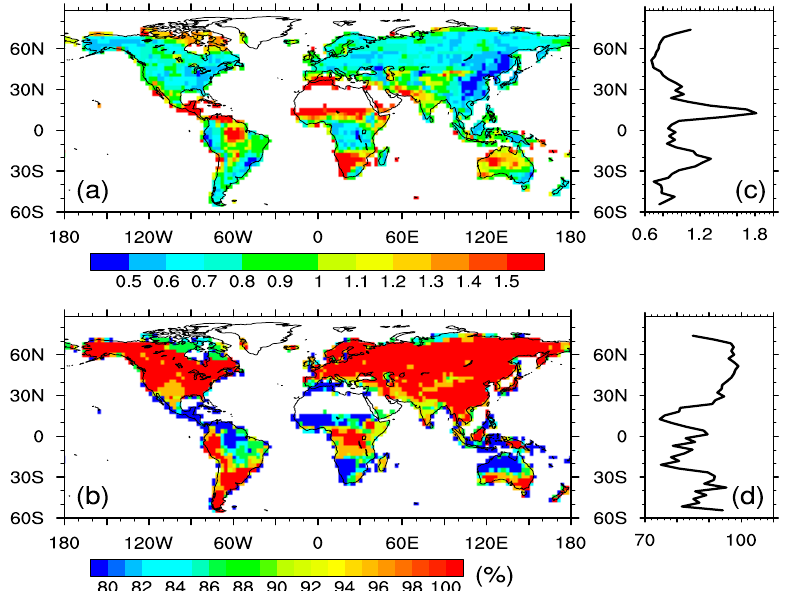
Figure 9. ( a ) shows one standard deviation of overall NPP anomalies among the 23 models. The values are standardized by the multi-model ensemble mean NPP anomaly. ( b ) is the percentage (%) of models that show the same direction as that of the ensemble in overall NPP anomalies. ( c , d ) correspond to zonal